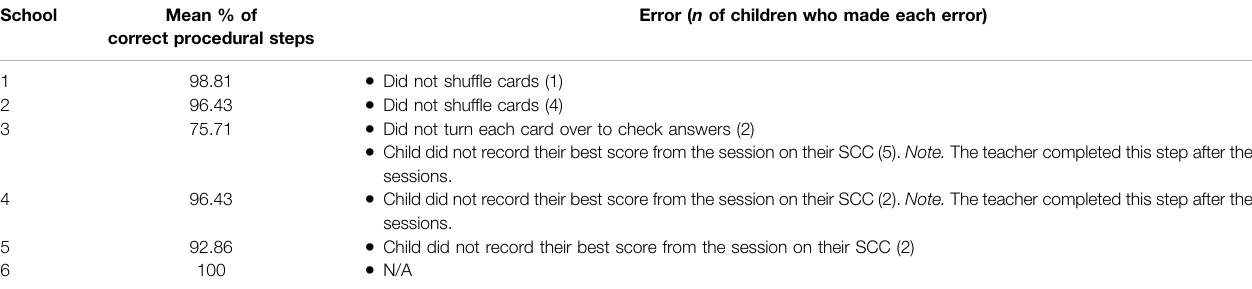
TABLE 6 | Percentage of SAFMEDS steps the children in each school adhered to.